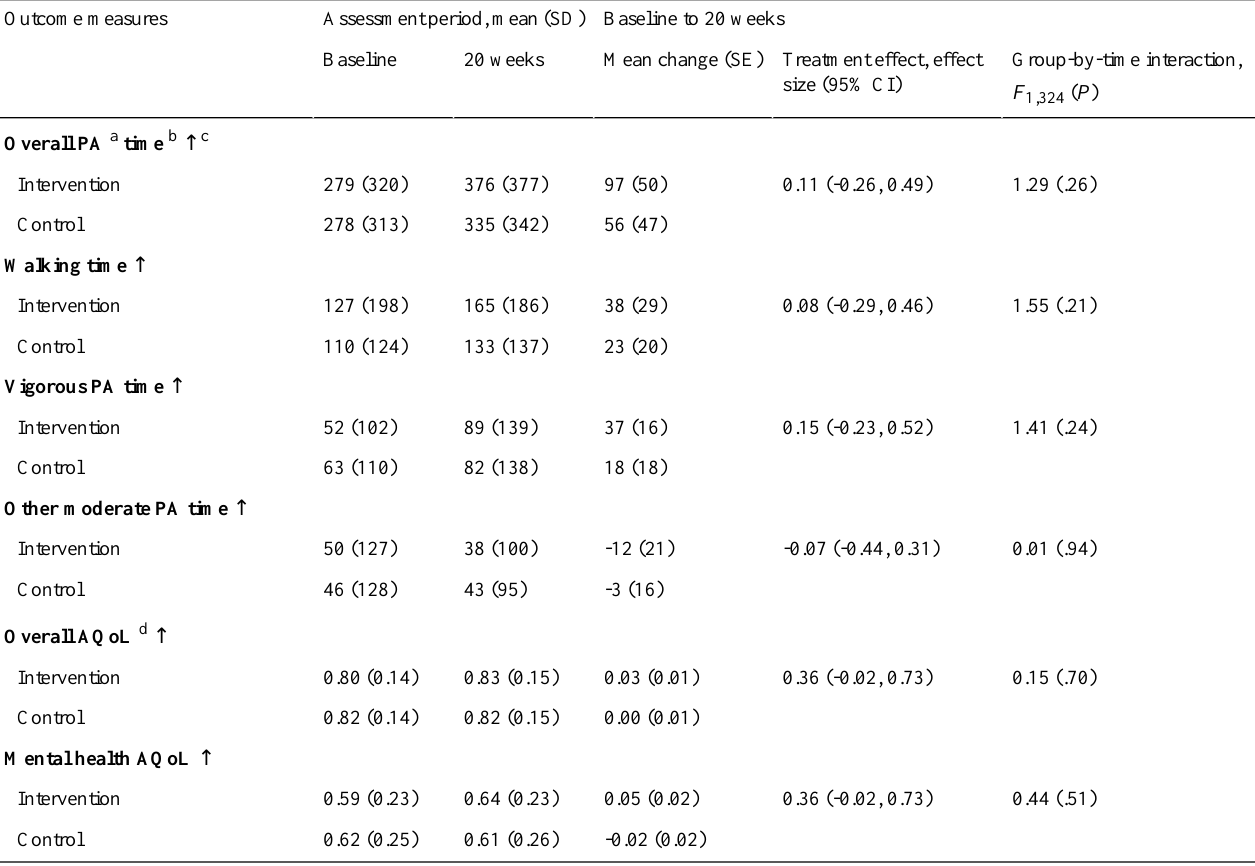
Table 3. Outcome measures at baseline and at 20-week follow-up.